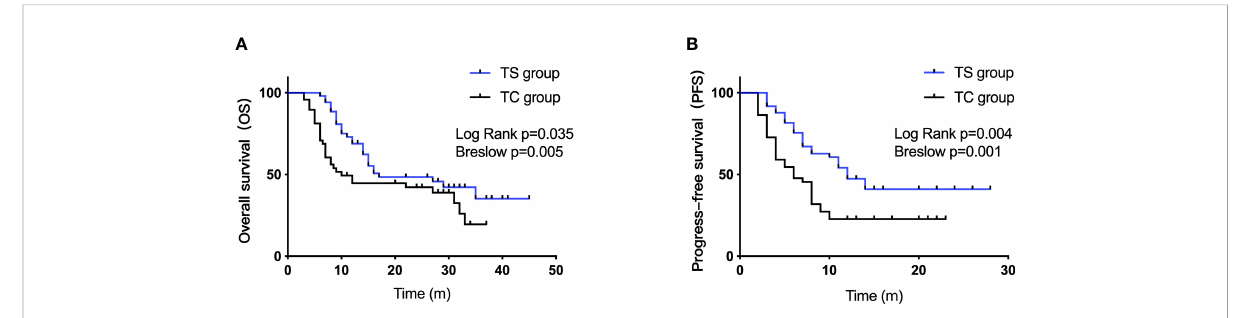
FIGURE 2 OS and PFS in the TS and TC group plotted by Kaplan-Meier